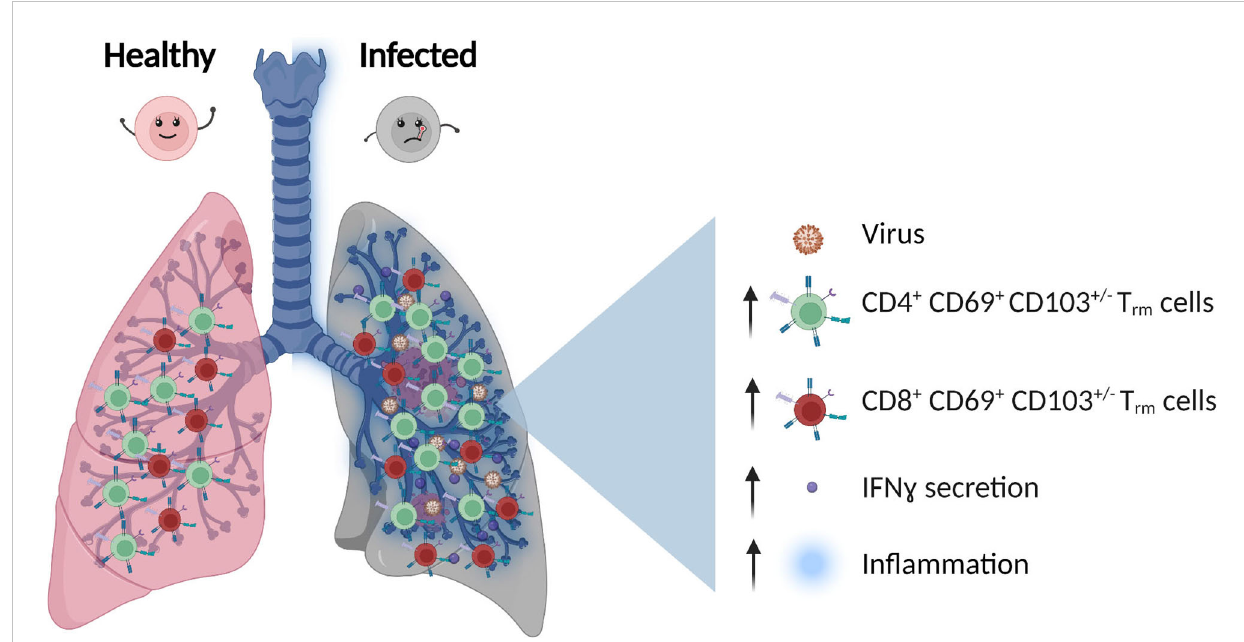
FIGURE 1 T Cells population in healthy vs infected lung. After viral infection, the number of CD4 + and CD8 + effector-memory, tissue-resident T cells (T rm ), and in fl ammatory cytokines secretion such as IFN g (Interferon gamma)